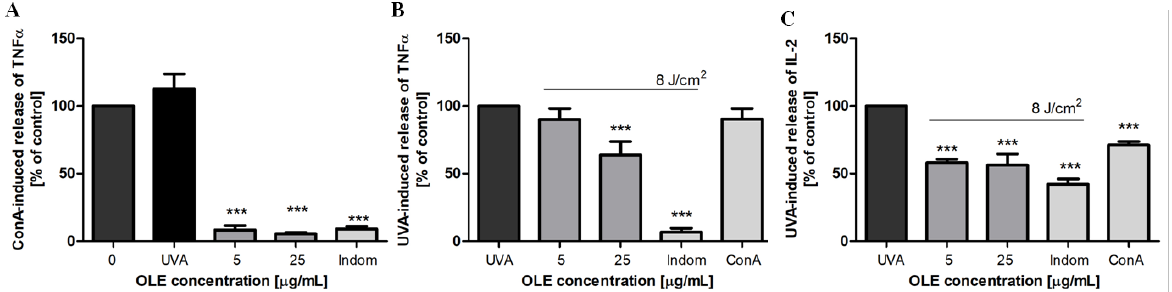
Figure 7. The effects of OLE on the concanavalin A ( A ) or UVA-induced ( B ) secretion of TNF- α and UVA-induced IL-2 release ( C ) by human peripheral blood polymorphonuclear cells. The results are expressed as % of control, where the cytokine level in untreated stimulated with ConA (10 µ g/mL) or UVA (8 J/cm 2 ) cells were taken as 100%. The figure shows mean results from 3 independent experiments. Error bars denote ± SD. *** p < 0.001 compared to stimulated cells in the absence of OLE (UVA). Indomethacin (25 μg/mL) was used as a reference.